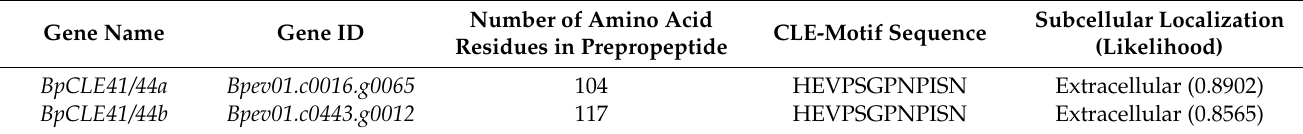
Table 2. The features of the B. pendula CLE41/44 members.